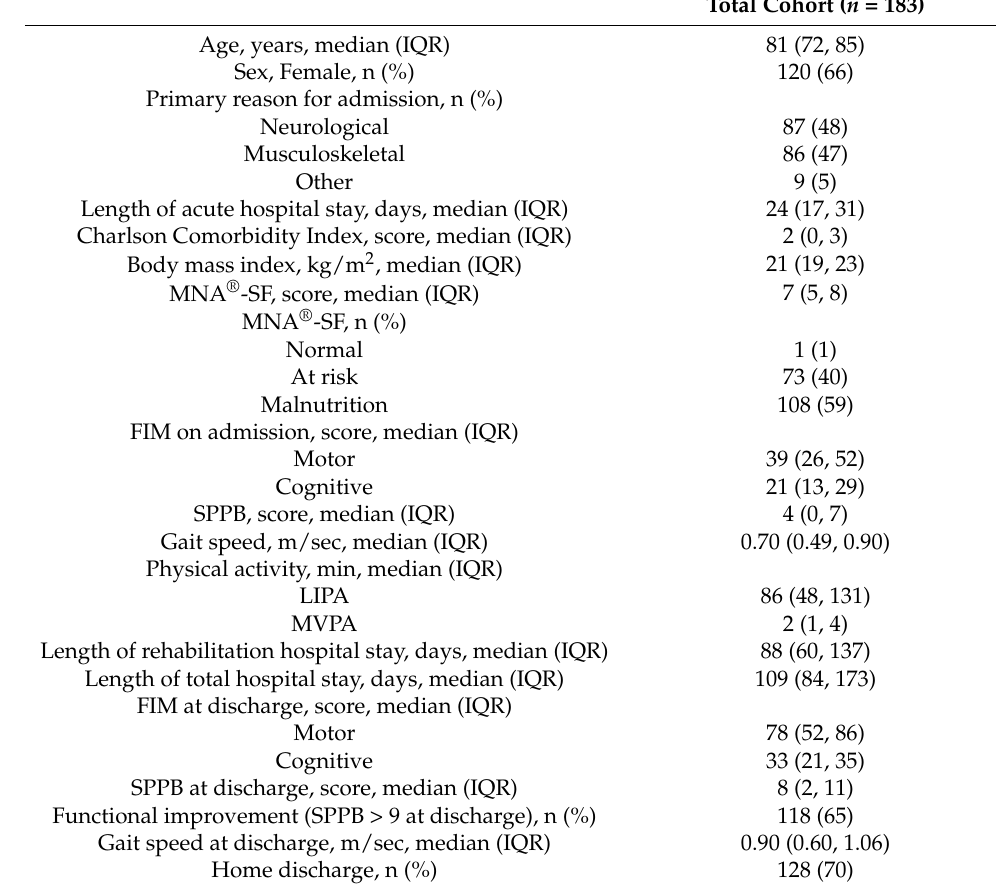
Table 1. Baseline characteristics at admission and the rehabilitation outcomes for all